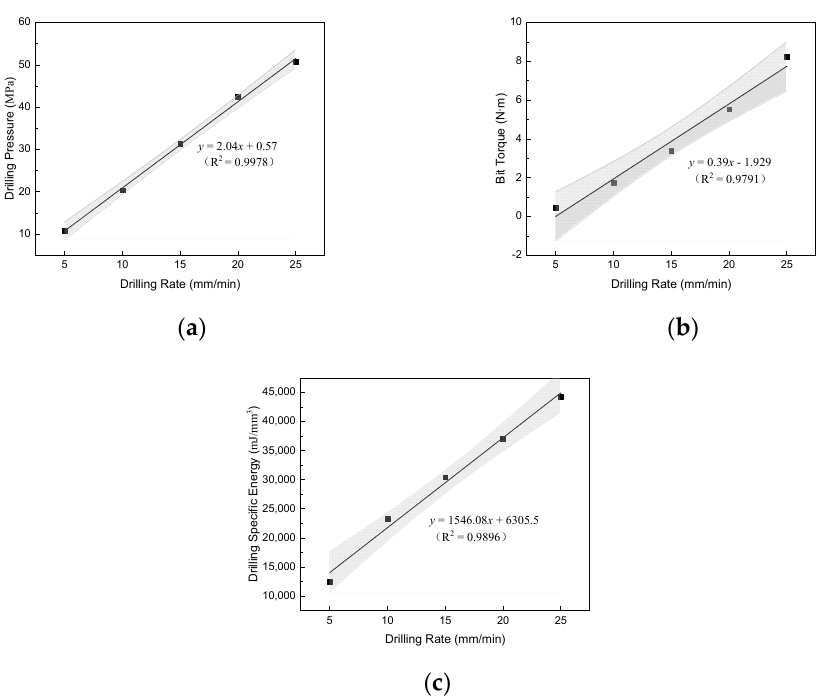
Figure 8. A shaded 95% confidence interval of bit drilling pressure ( a ), torque ( b ), and specific energy ( c ) at varied drilling rates.